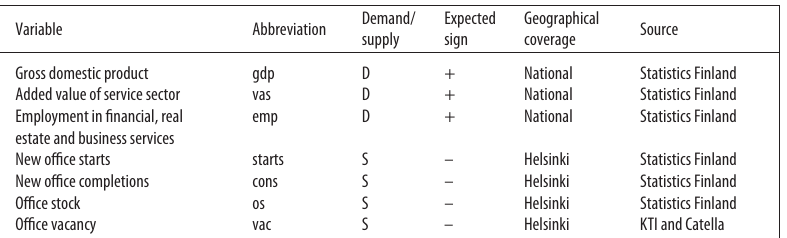
that represent flow variables were differenced.